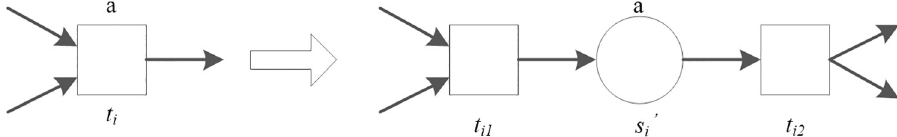
Fig 4. Non-transient transitions replaced by time value